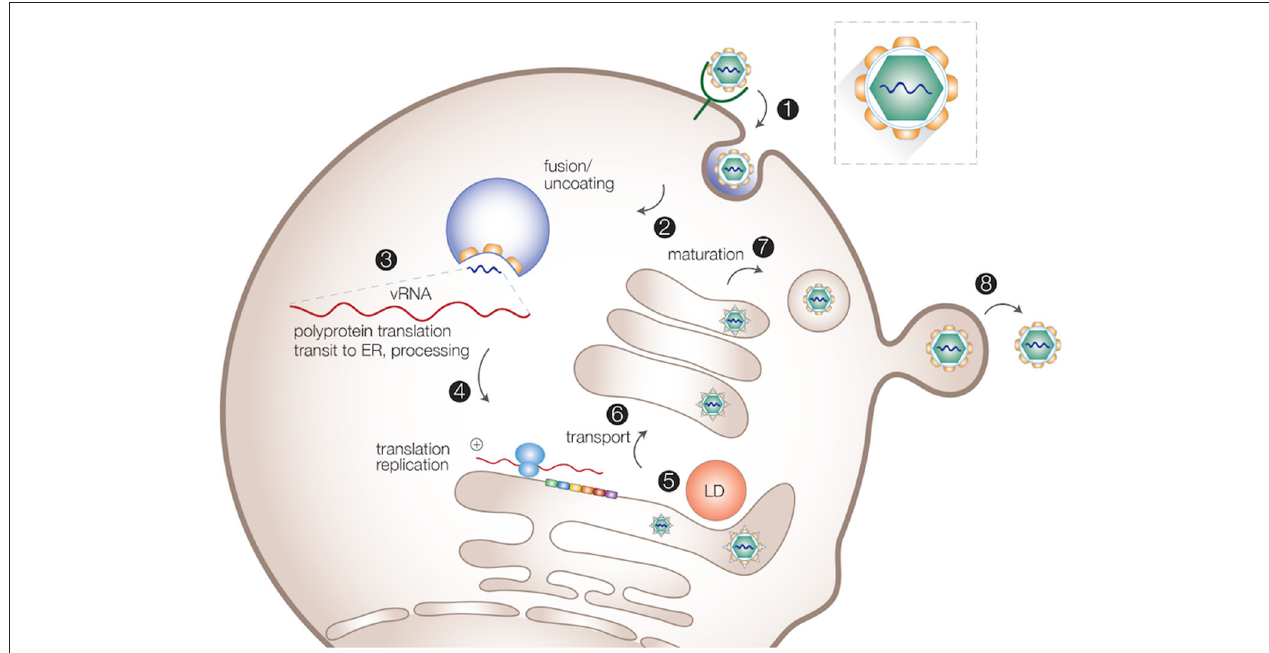
FIGURE 1 | Intracellular life cycle of flaviviruses. Viral particles are internalized via receptor-mediated endocytosis (1). After the uncoating of viral particles (2), viral RNA is released into cytosol for translation and replication (3,4). Progeny virions are assembled in close proximity to the ER and LDs (5). Virions are transported through the host secretory pathway and undergo maturation (6,7). Mature virions are released from the cell surface